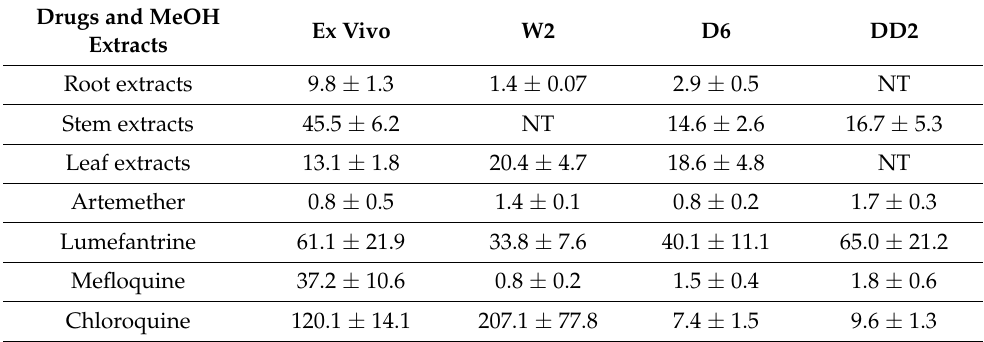
Table 1. Mean IC 50 s values (ng/mL) of drugs and S. longipedunculata methanol extracts. Drugs and MeOH Ex Vivo Extracts Root extracts